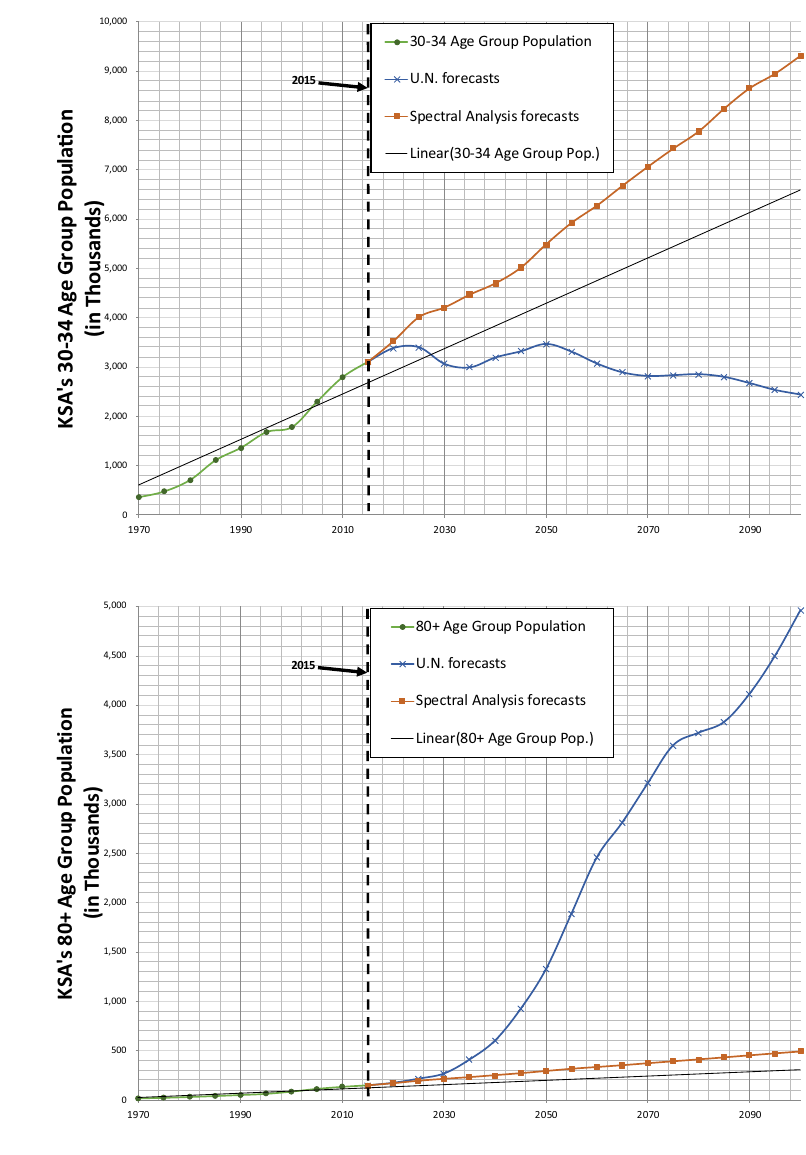
30-34 Age Group Popula(cid:2)on